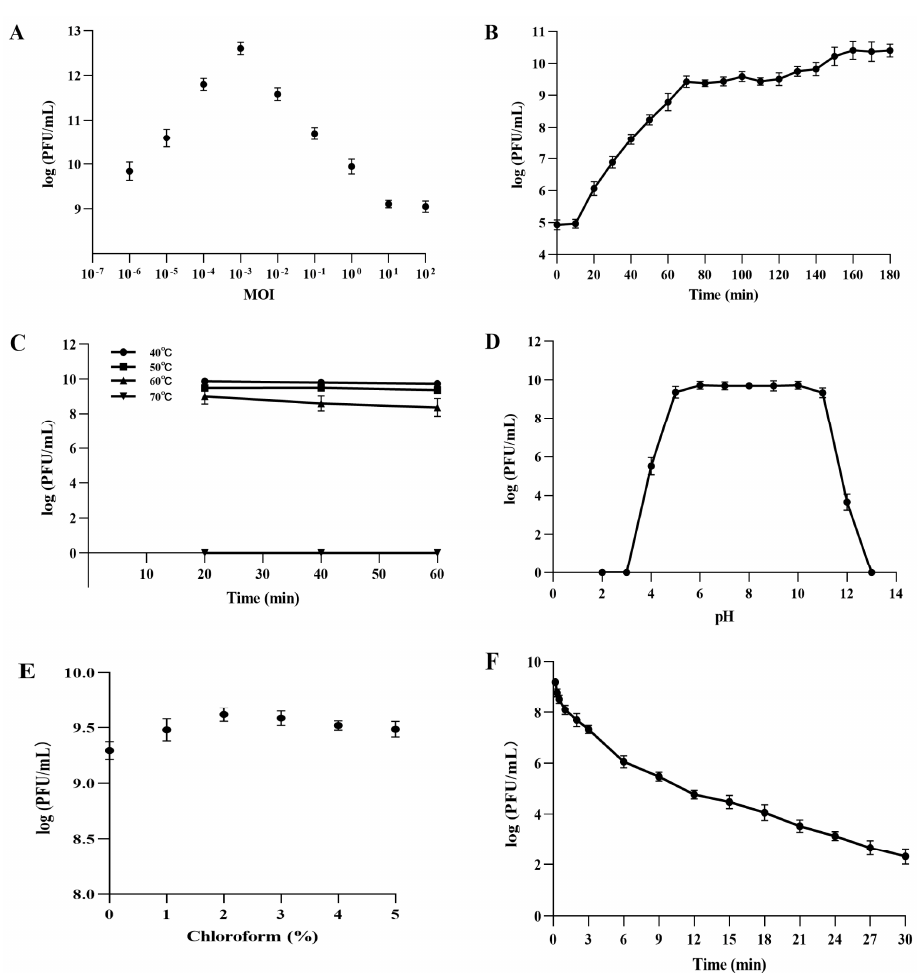
Figure 4. Biological characteristics of PVA23. ( A ) The MOI test of PVA23; ( B ) The one-step growth curve of PVA23; ( C ) The thermal stability test of PVA23; ( D ) The pH stability test of PVA23; ( E ) Chloroform sensitivity test of PVA23, and ( F ) Ultraviolet (UV) sensitivity test of PVA23.